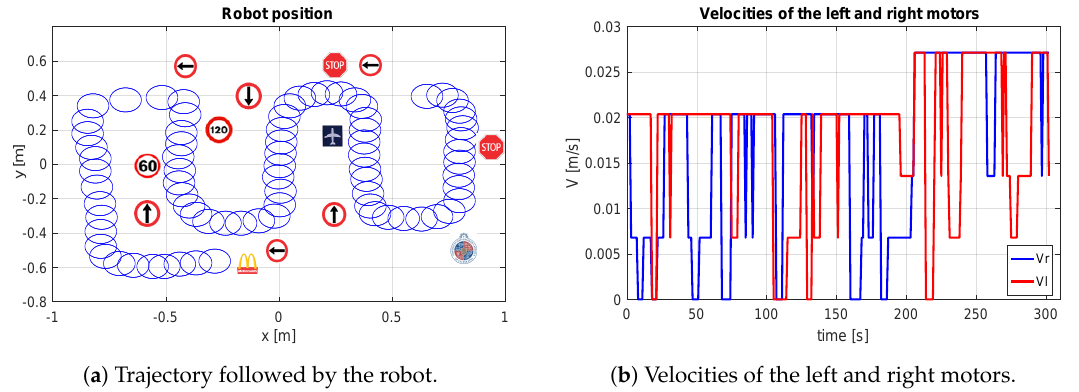
Figure 15. Results of the experiment developed in the real environment.